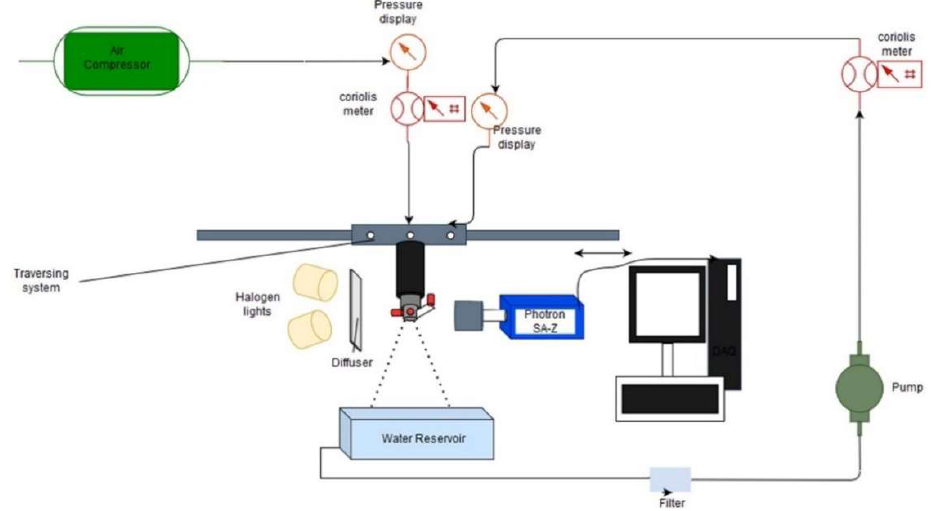
Figure 3. Schematic of the experimental setup for sheet breakup